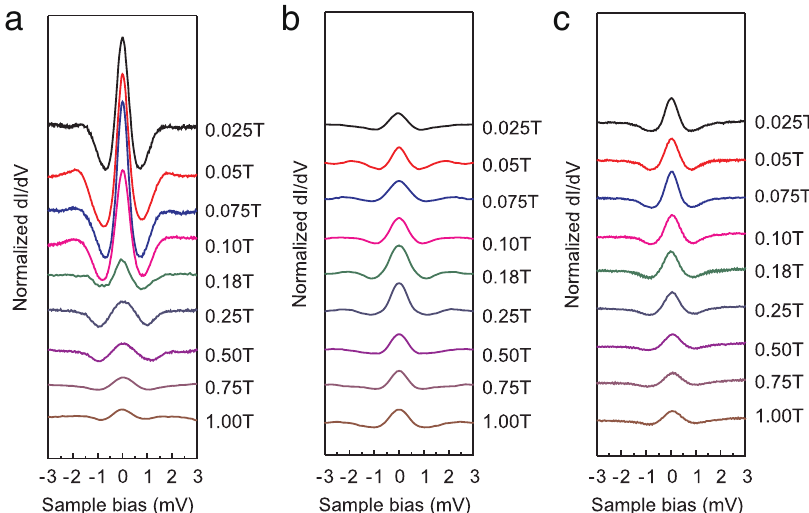
Fig. 5 A series of STS spectra measured at various magnetic fi elds at a vortex center of 5 QL Bi 2 Te 3 /NbSe 2 a , bare NbSe 2 , b and 2 QL Bi 2 Te 3 / NbSe 2 c . A dramatic drop in the peak intensity is clearly seen at 0.18 T in ( a ). a – c reprinted with permission from ref. 16, copyright 2015 by the American Physical